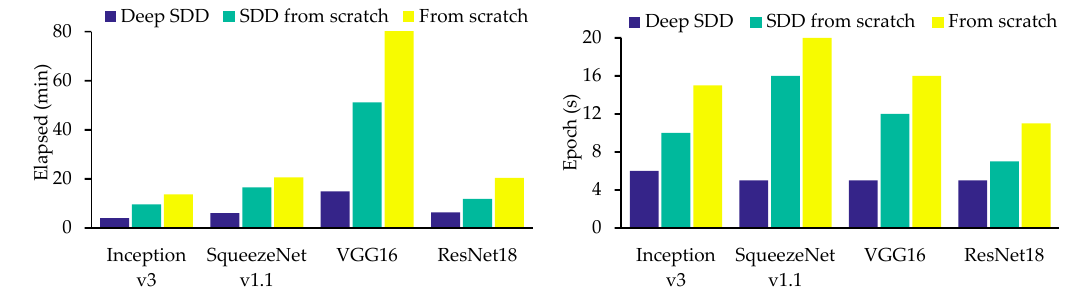
Figure 7. Comparison of elapse and epoch for convergence for different models.